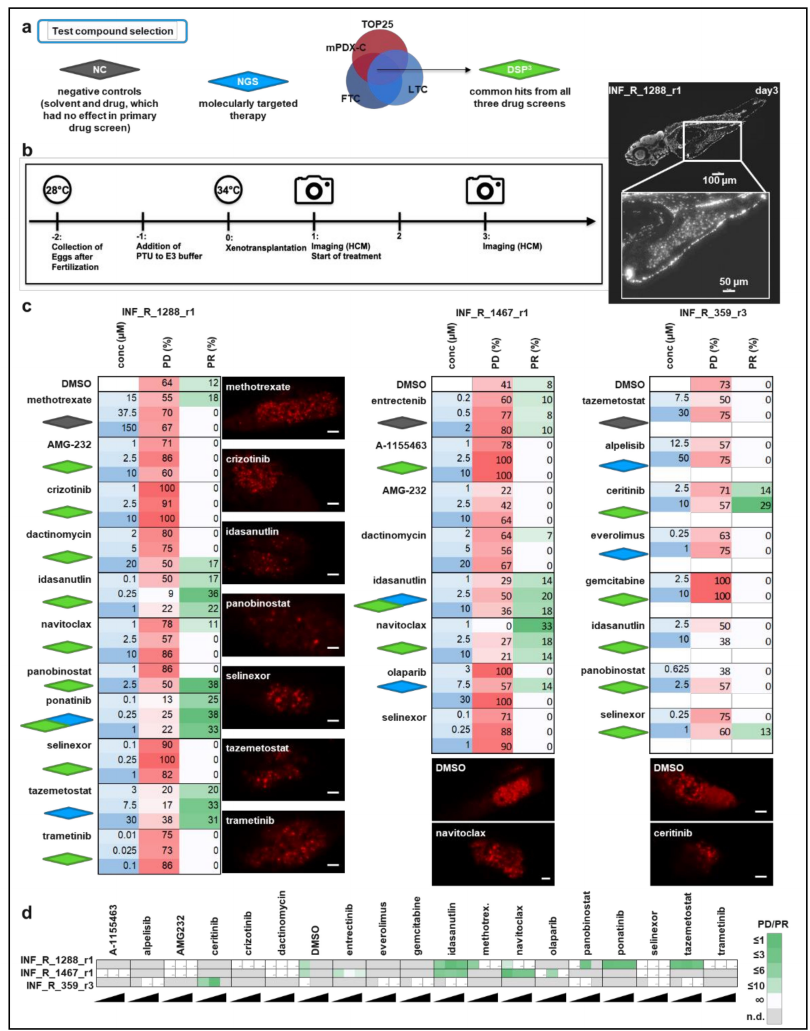
Figure 4. In vivo drug hit validation with the zPDX tumor growth model. ( a ) Scheme of hit selection for validation experiments. ( b ) Scheme and timeline of experimental setup. Fluorescently labeled tumor cells were injected into the yolk sac on experimental day zero and from that time point on, the embryos were kept at 34 ◦ C. The treatment started on experimental day one. Imaging of the embryos was performed on experimental day one before treatment and on day three (the end of the experiment). Microscopic images on the right of the timeline display an untreated day three tumor at two magnifications (scale bar 100 µ M; inlay: scale bar 50 µ M). Nuclei were stained with DAPI to visualize the tumor cells in the yolk sac. ( c ) Effects of drug of interest on tumor growth in the zPDX model. Tumor progression was monitored by automated quantification of tumor volume on day one and day three according to Response Evaluation Criteria in Solid Tumors (RECIST) 1.1 adopted for zebrafish tumors. Numbers indicate the percentage of early larvae with PD (red color) or PR (green color) in each treatment group on day three. Buffer-applied concentrations in µ M are marked in blue. Grey diamonds: negative control treatments; green: DSP common hit in all three culture models; blue NGS suggested hit. Number of embryos per treatment group for INF_R_1288_r1 ( n = 4–42, pooled from two experiments), INF_R_1467_r1 ( n = 5–39, pooled from two experiments) and INF-R-359_r3 ( n = 7–8, from one experiment). Images aside or below the heatmap display DiI-stained tumor cells of the respective model with selected treatments on day three. Scale bar: 50 µ M. ( d ) Heatmap reflecting the ratio of PD to PR (green shading) for all treatments and all models ( n = 4–42). Grey: not detected (n.d.); ∞ : the percentage of PR was 0%. PD: progressive disease, tumor volume must have increased at least 20%; PR: partial response, tumor volume must have decreased by more than